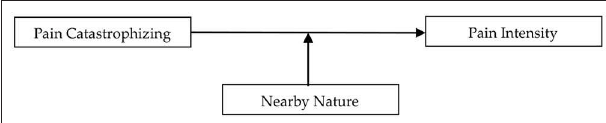
FIGURE 1 | RQ1 Does nearby nature moderate the pain catastrophizing—pain intensity relation?